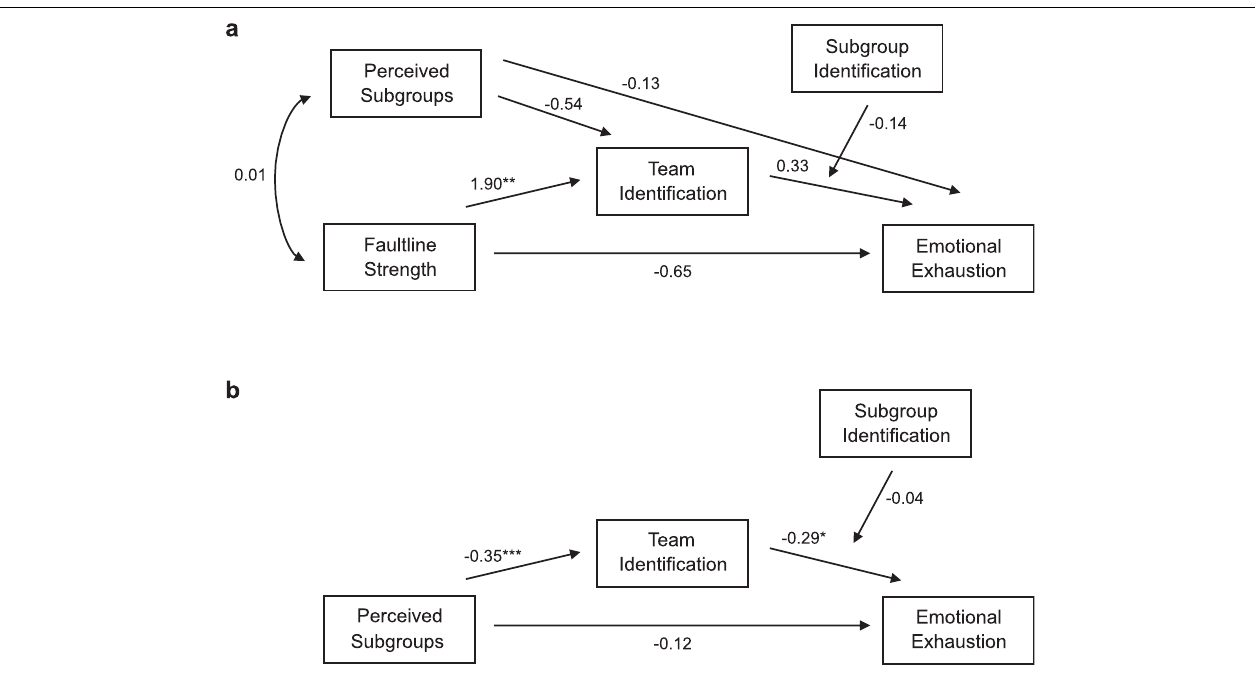
FIGURE 3 | (a) Between and (b) within effects of the tested multilevel path model for Hypothesis 2. Note that for the sake of clarity, the control variables are not presented in this diagram although they were included in the analysis. * p < 0.05, ** p < 0.01, *** p <